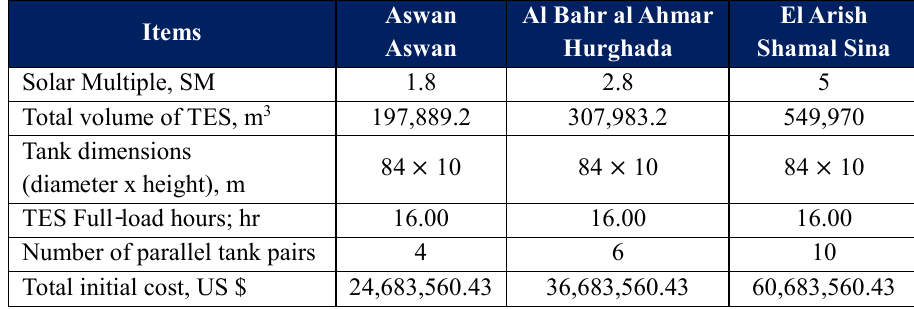
Table 6 Cost analysis for storage tank.